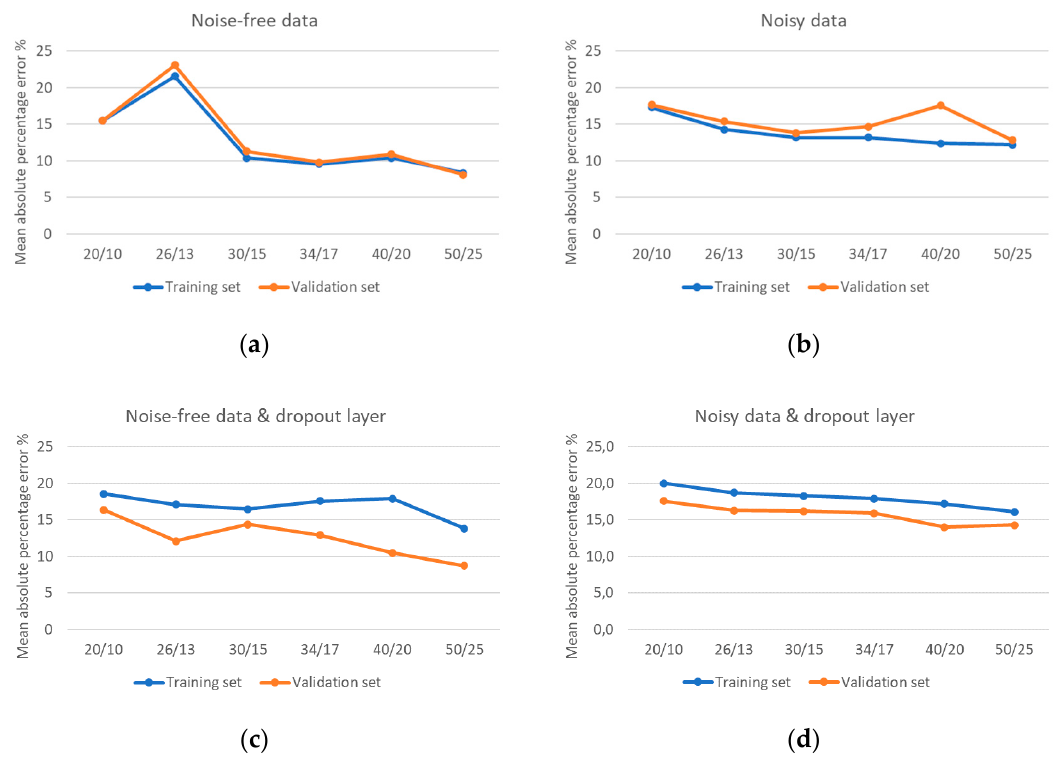
Figure 8. ( a – d ): Mean absolute percentage error obtained for various network architectures and with respect to existence of noise in the training and validation data sets.